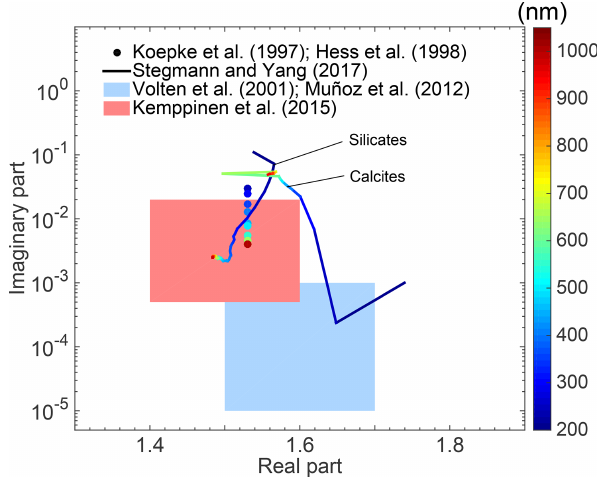
Figure 1. Refractive index from different sources. The color bar indicates the wavelengths at which the corresponding refractive in- dices are given (for the two lines and